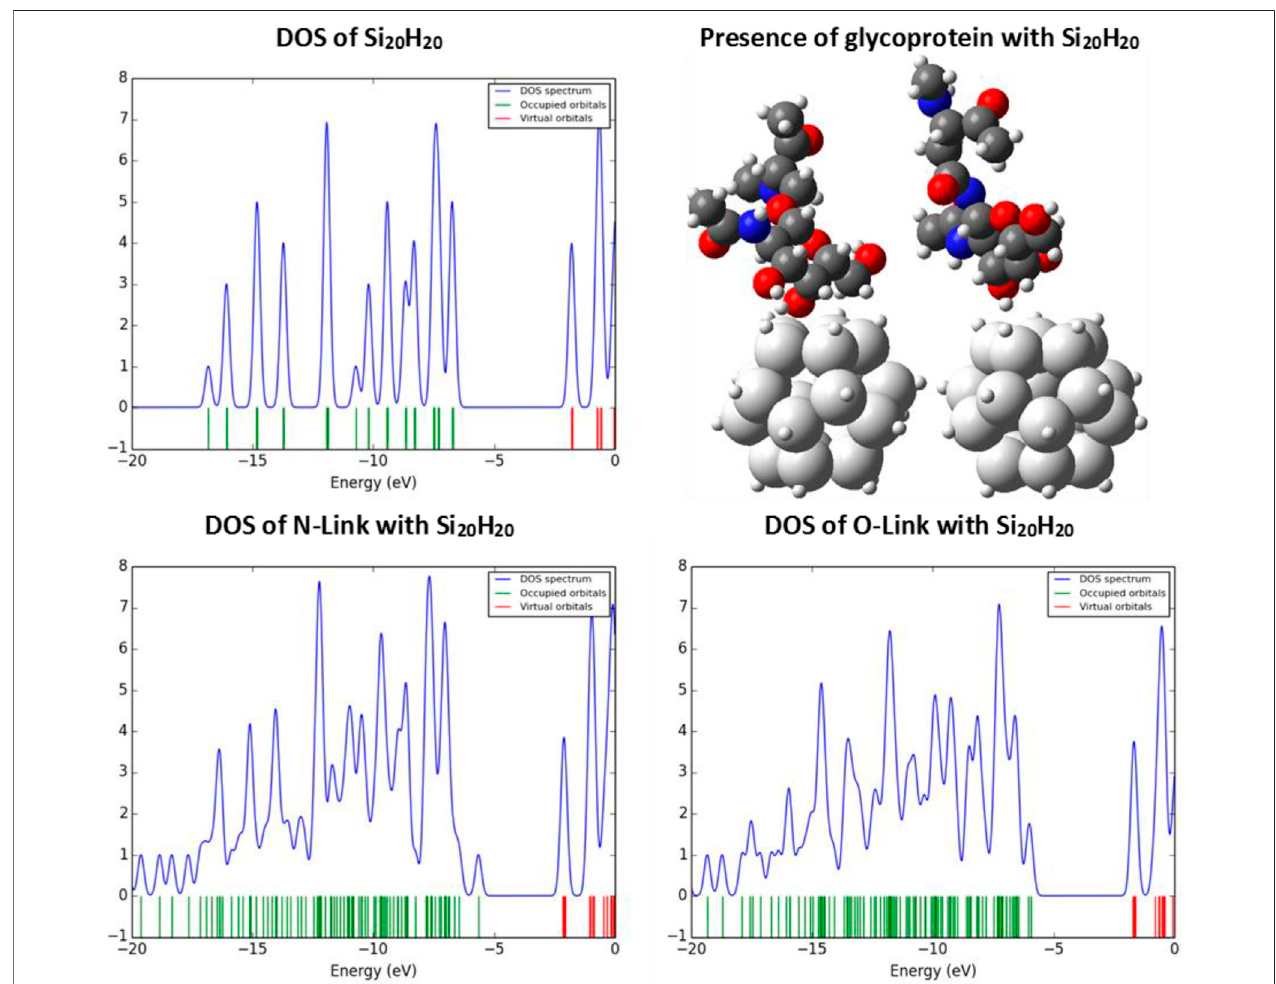
FIGURE 5 | The DOS diagrams of the Si 20 H 20 in the absence and presence of N- and O-Link glycoproteins.